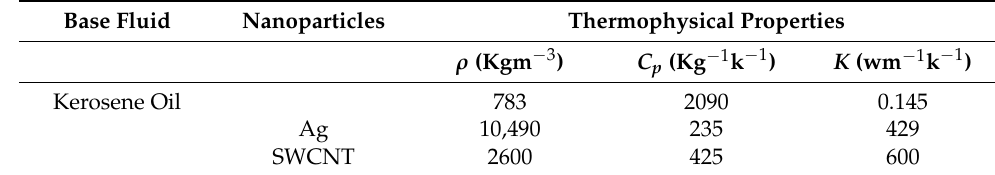
Table 2. Different properties of the base fluid and nanoparticles utilized in the study [7,15,51,56,57].